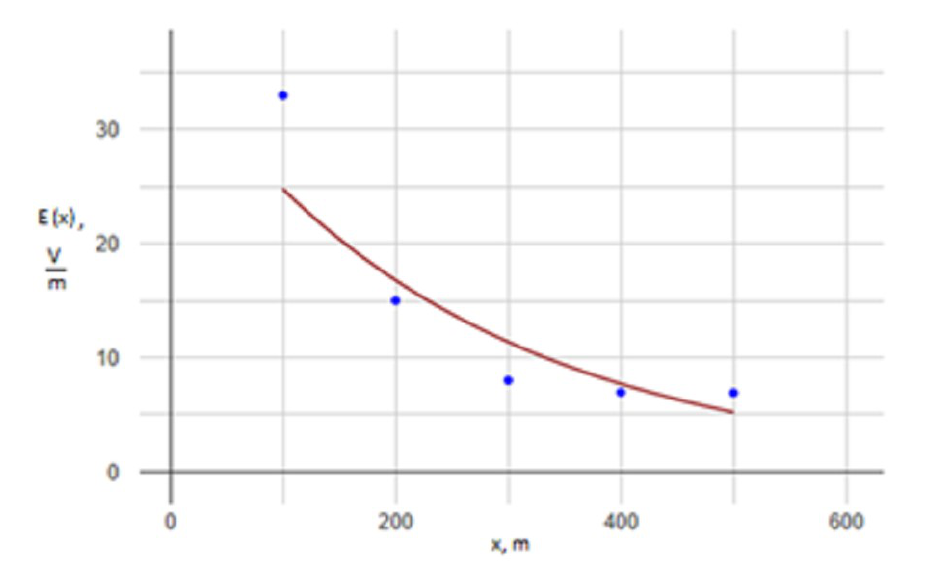
Fig. 10. Dependence of signal amplitude on the distance between the antennas. Signal frequency is 28,5